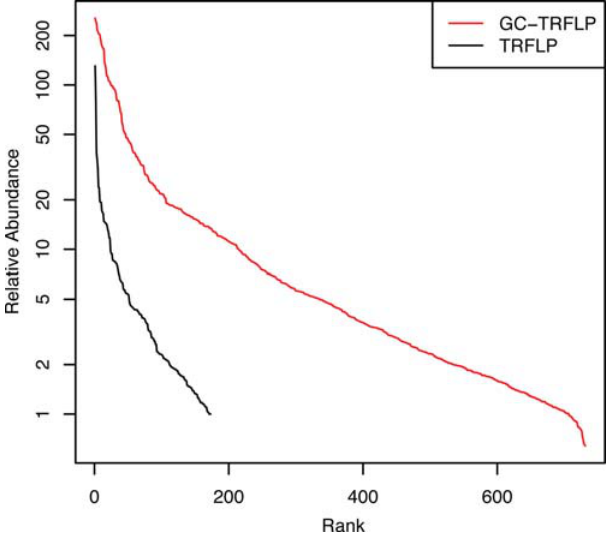
Figure 2. Rank abundance of both GC-TRF and TRF peak height values for GC-TRFLP and TRFLP performed on the same soil sample. The GC-TRFLP data represents 731 OTUs, while the TRFLP data represents 173